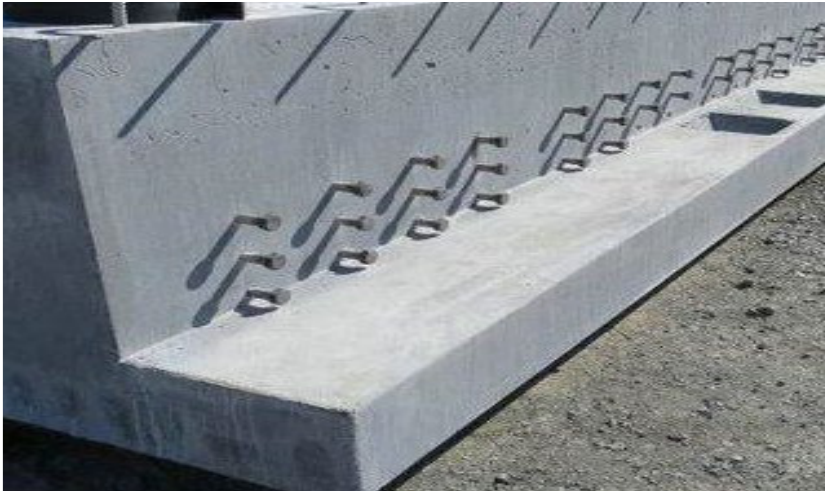
Figure 2. Ultra high-performance concrete (UHPC).